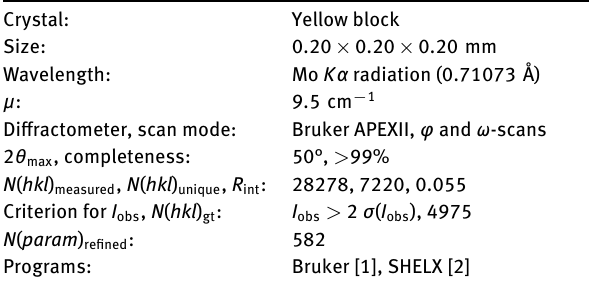
Table 1: Data collection and